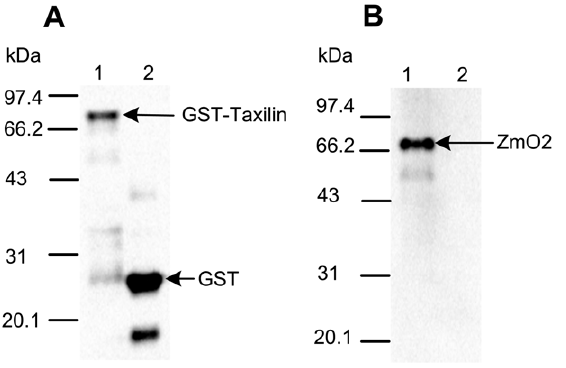
Figure 3. ZmTaxilin and ZmO2 interact in a GST pull-down assay. ( A ) Western blot detection of the GST pull-down sample with a GST antibody. The kernel sample was a pool of equal amounts of RNA from different developmental stages between 3 and 36 days after pollination (DAP). ( B ) Western blot detection of the GST pull-down sample with the ZmO2 antibody. Lane 1 in ( A ) and ( B ): E. coli lysate containing the GST-Taxilin protein and the maize seed protein containing ZmO2. Lane 2 in ( A ) and ( B ): E. coli lysate containing GST and maize seed protein containing ZmO2. The expected molecular weight of the GST-Taxilin fusion protein, the GST tag and ZmO2 are 75.397, 27.895 and 47.075 kDa, respectively. The apparent molecular weight of the ZmO2 protein was approximately 68–72